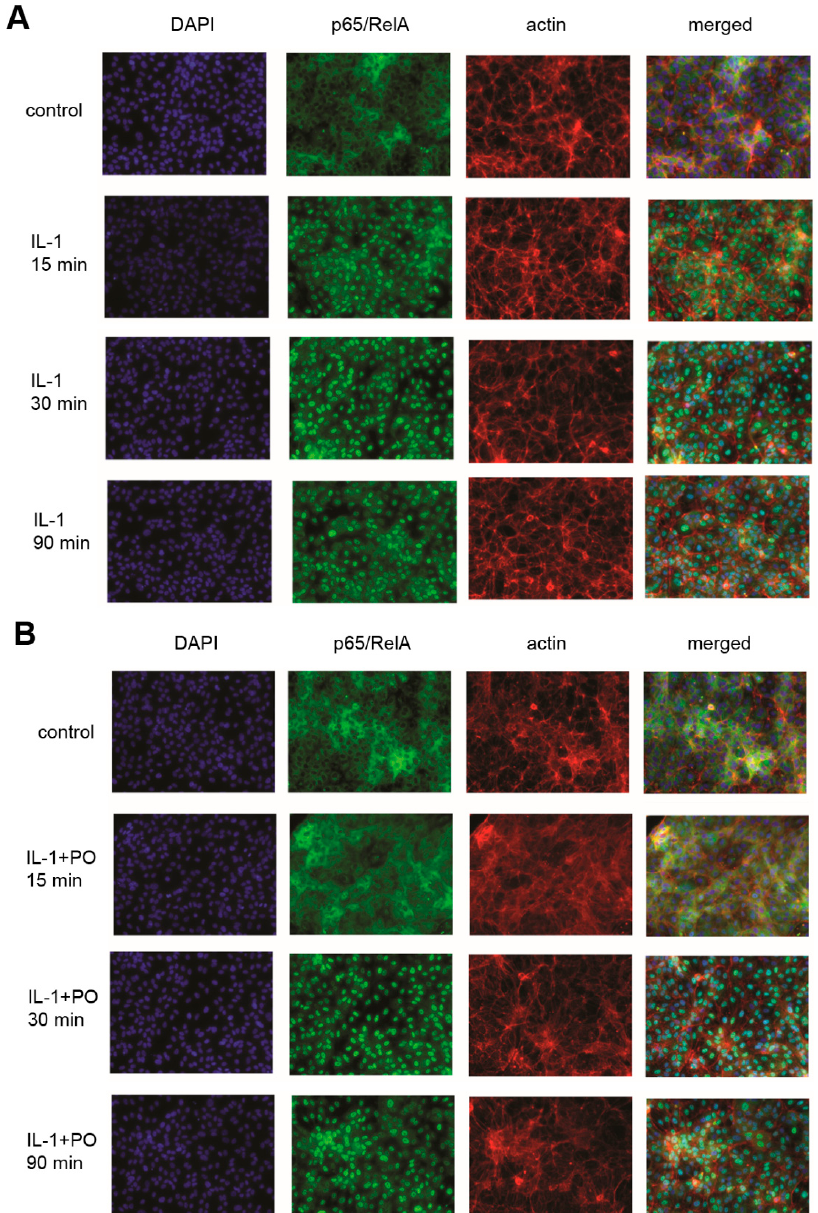
Figure 5. PO delays nuclear translocation of NF- κ B. HUVEC were either ( A ) stimulated with 5 ng / mL IL-1 alone for the indicated times or ( B ) pre-treated for 30 min with 50 ng / mL PO before IL-1 stimulation, and immunostained for the p65 / RelA subunit of NF- κ B (green) and actin (red). Nuclei were stained with DAPI (blue). Merged pictures are shown on the right.